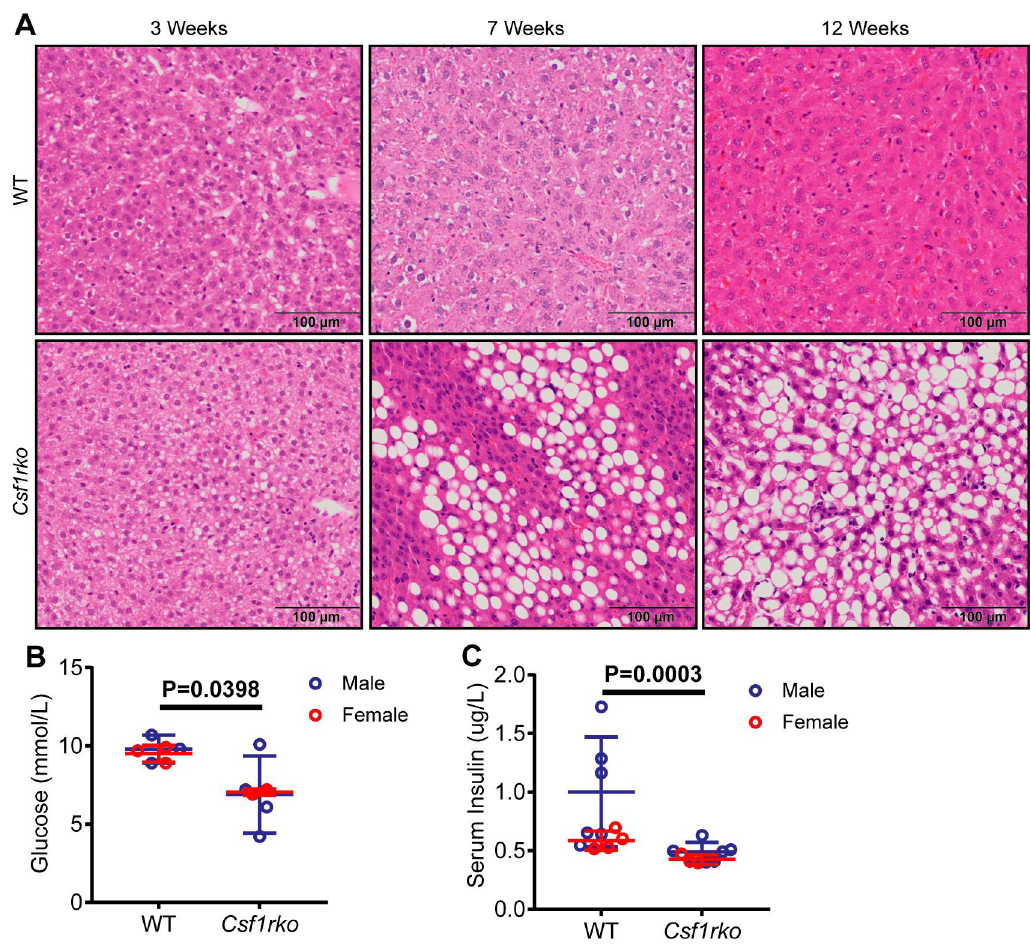
Fig 5. Histological analysis of lipid accumulation in the liver and quantitative measures of blood glucose and serum insulin. (A) Representative images of H&E staining in the liver of WT (top panel) and Csf1rko (bottom panel) rats at 3 wks (left panels), 7 wks (middle panels) and 12 wks (right panels). (B) Blood glucose and (C) serum insulin levels measured at 3 wks in WT and Csf1rko rats. n � 6 per genotype, graphs show the mean ± SD, genotype comparisons were analysed by Mann Whitney